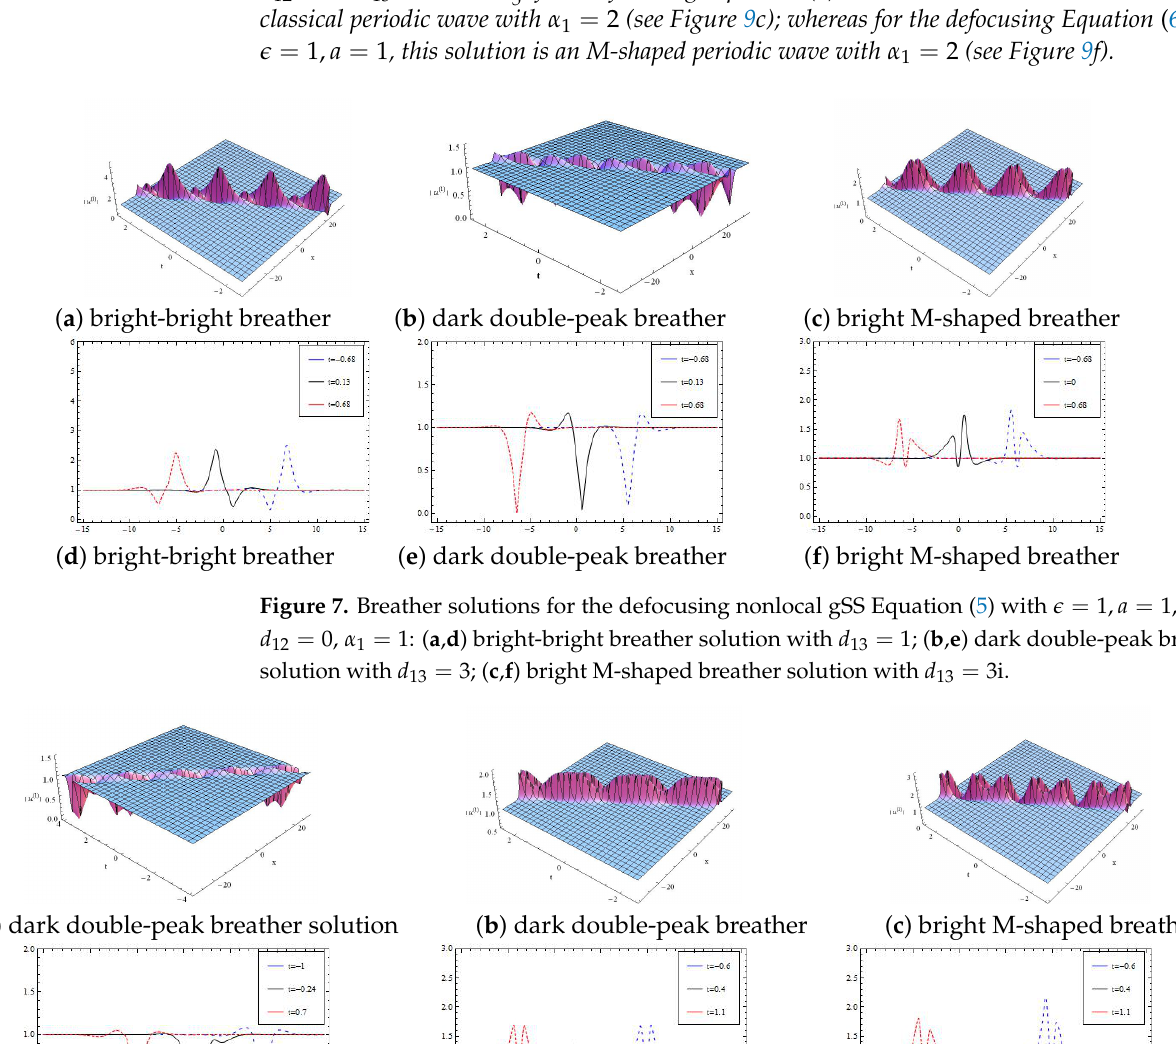
Figure 8. Breather solutions for the focusing nonlocal gSS Equation (5) with (cid:101) = 1, a = − 1, b = 2, d 12 = 0, α 1 = 1: ( a , d ) dark double-peak breather solution with d 13 = 1; ( b , e ) M-shaped double-peak- breather solution with d 13 = i; ( c , f ) M-shaped double-peak-breather solution with d 13 = 3i. + d ∗ When d 12, I (cid:54) = 0 , d 13, R (cid:54) = 0 , and d 12 d ∗ d 13 (cid:54) = 0 , this solution is breather-periodic wave 13 12 solution. In Figure 10, taking (cid:101) = 1, b = 1 , for the focusing case with a = − 1, α 1 = 1 , this 5 2 solution is a double-peak breather-periodic wave solution with d 12 = 1 + i , d 13 = 2 or d 12 = i , 2 d 13 = 1 + i (see Figure 10a–d); for the defocusing case with a = − 1, α 1 = 3 : this solution is 2 breather-periodic wave solution with d 12 = i , d 13 = 1 + i or d 12 = 1 + i , d 13 = 2 (see Figure 2 2